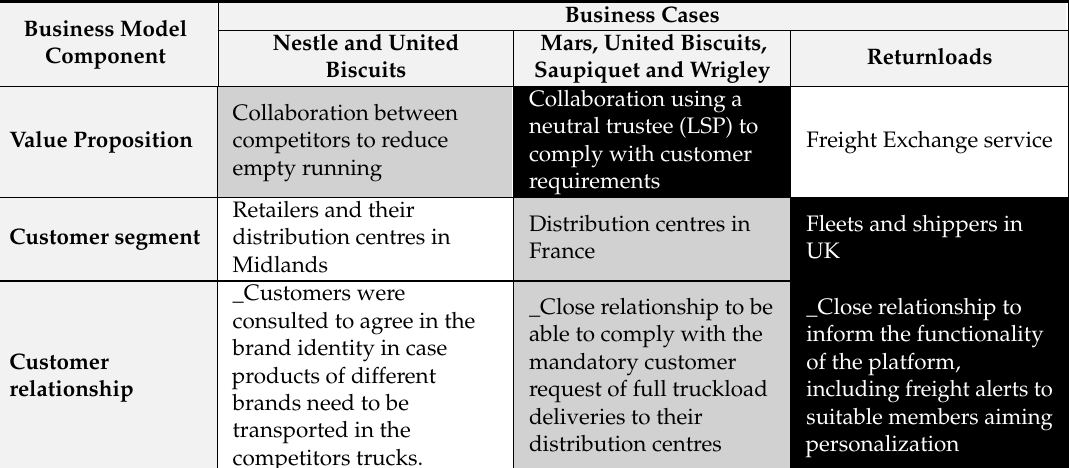
Table 4. Business model building blocks categorization for freight industry collaboration business